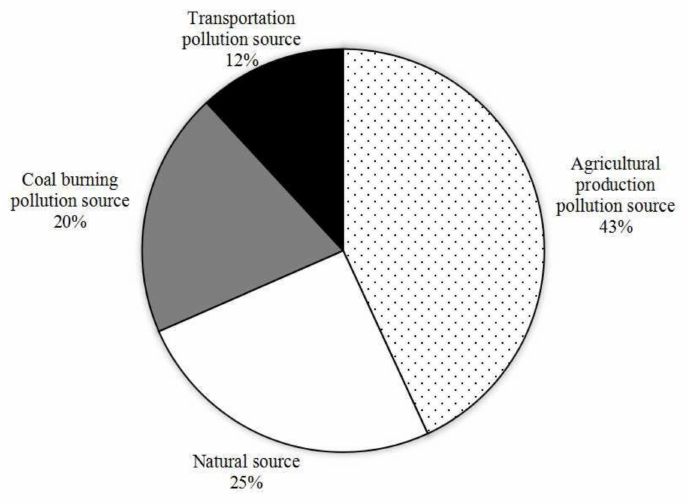
Figure 7. Contributions rate of di ff erent sources by